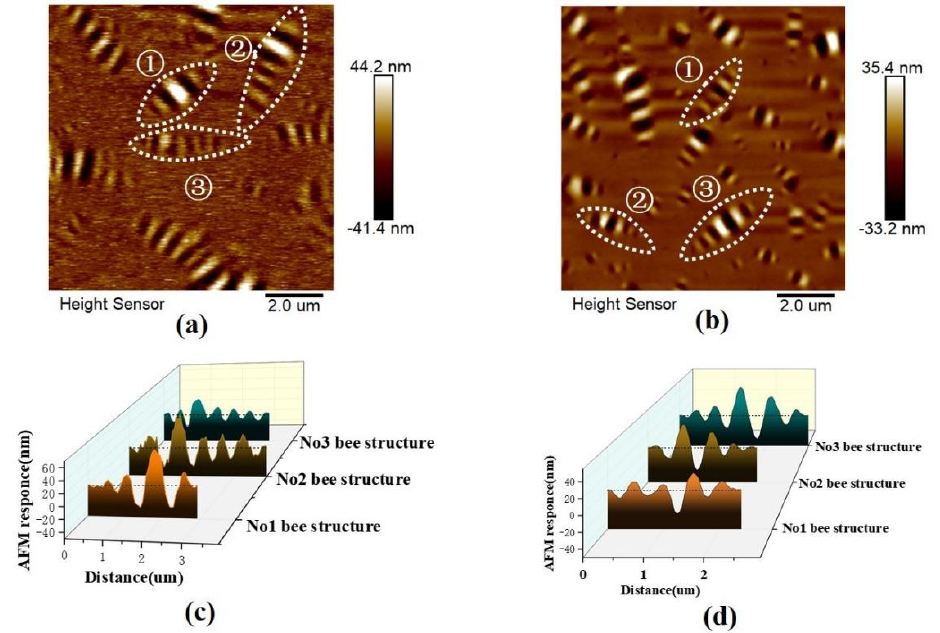
Figure 3. Topographies of asphalt investigated via AFM. ( a ) 2D image of base asphalt; ( b ) 2D image of graphene-modified asphalt; ( c ) topographic profiles of “bee structures” labeled in ( a ); ( d ) topographic profiles of “bee structures” labeled in ( b ).